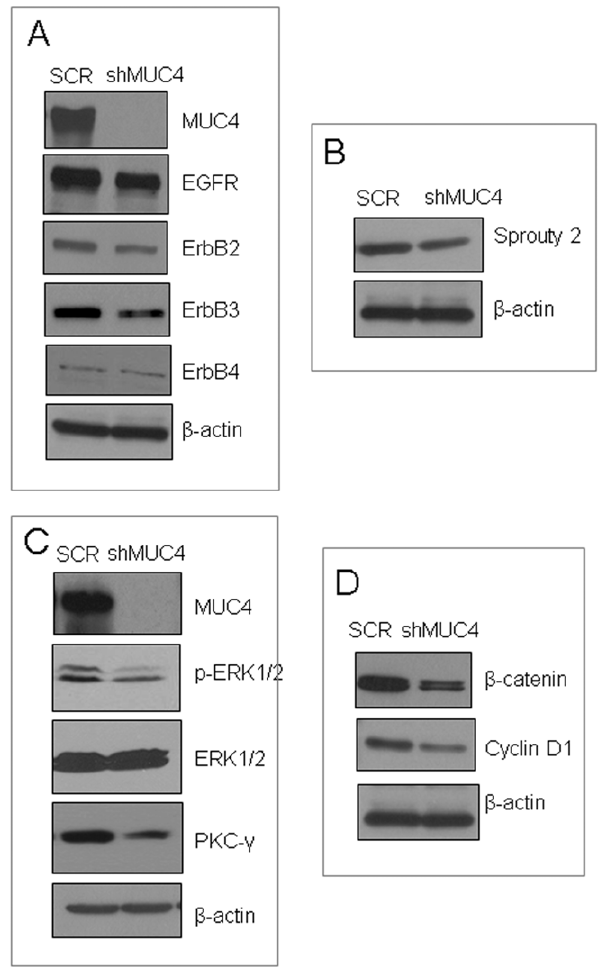
Figure 2. MUC4 up-regulates EGFR family receptors and induces downstream Erk1/2 and PKC- c pathways. ( A ) Immuno- blot analyses showed reduced expression of EGFR, ErbB2, and ErbB3 in MUC4 knockdown cells compared with control cells. ( B ) Reduced expression (using immunoblot) of Sprouty 2 was detected in MUC4 knockdown cell when compared with control cells. ( C ) Immunoblot showed that reduced phosphorylation of Erk1/2 and expression of PKC- c in MUC4 knockdown cells compared with control cells. b -actin was used as a loading control. ( D ) Immunoblot analyses showed reduced expression of b -catenin and its target gene product cyclin D1in MUC4 knockdown compared with control cells.